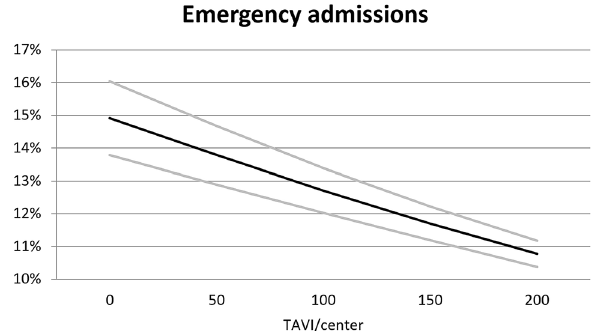
Figure 1. Proportion of emergency admissions in all TAVI interventions per center in Germany in 2018. Predicted emergency admissions (black line) and 95% confidence intervals (grey lines), divided up according to the total number of TAVI cases treated per hospital and year.